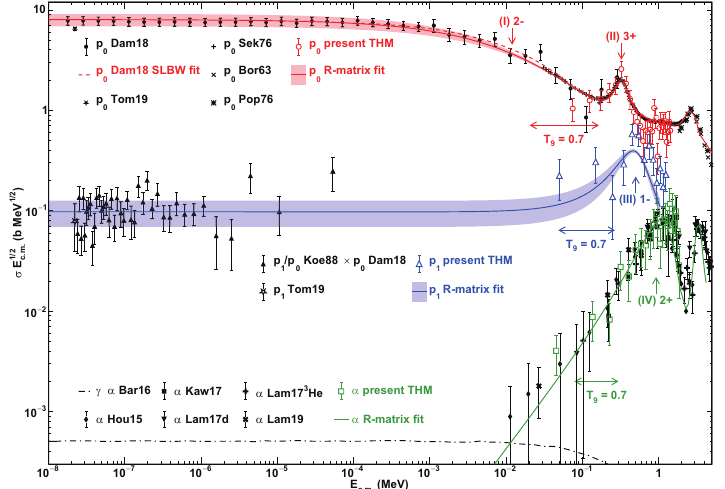
p Figure 1. The cross sections multiplied by E cm of the 7 Be( n ; p 0 ) 7 Li, 7 Be( n ; p 1 ) 7 Li (cid:3) and 7 Be( n ;(cid:11) ) 4 He reactions in [6] are shown as open red circles, blue triangles, green squares, respectively. The previous experimental data are also shown for comparison. See [6] for